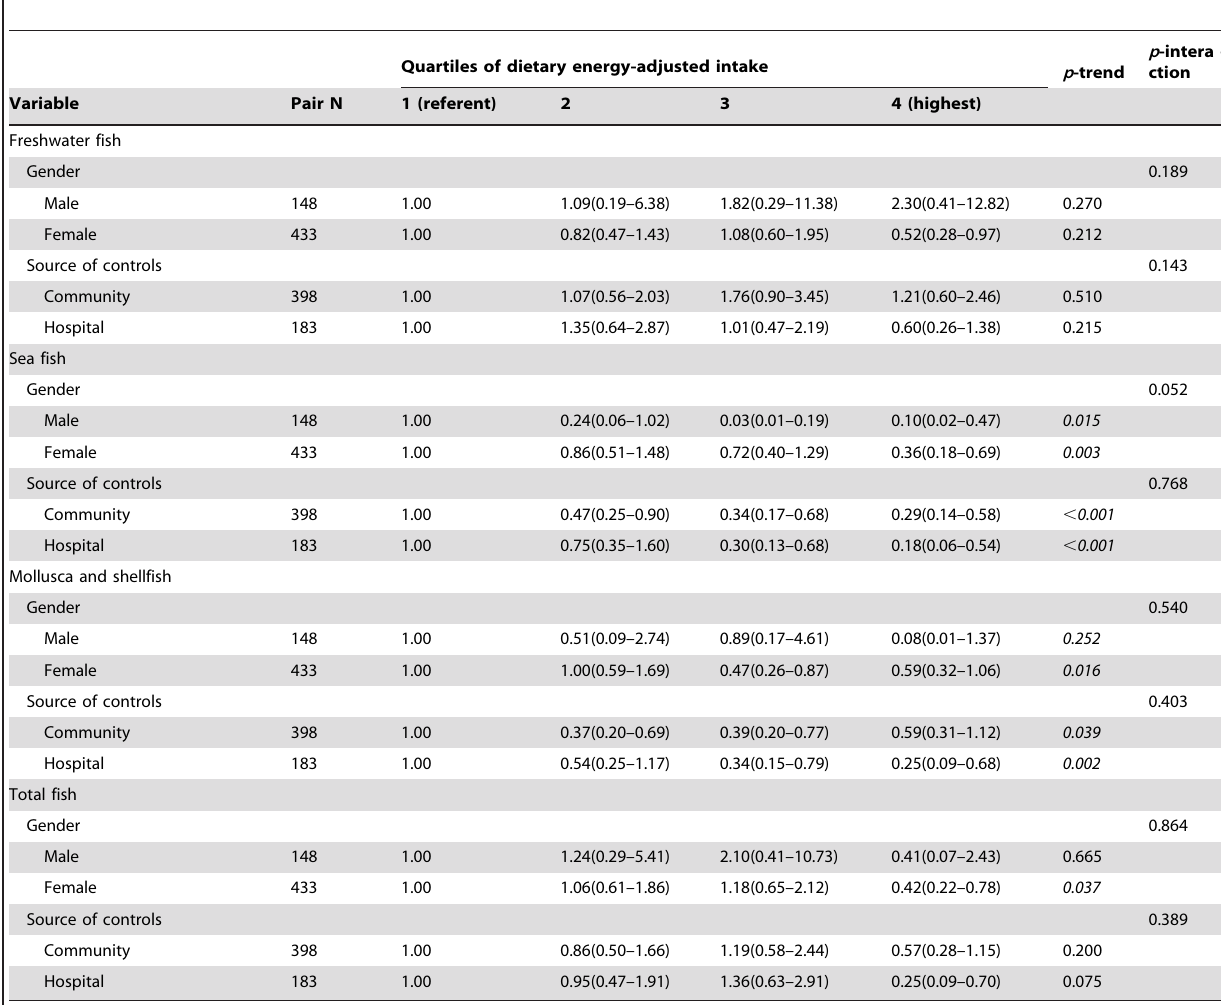
Table 5. Odds ratio (95% CIs) of hip fractures for quartiles of seafood stratified by gender, source of controls, and fracture sites in Guangzhou,